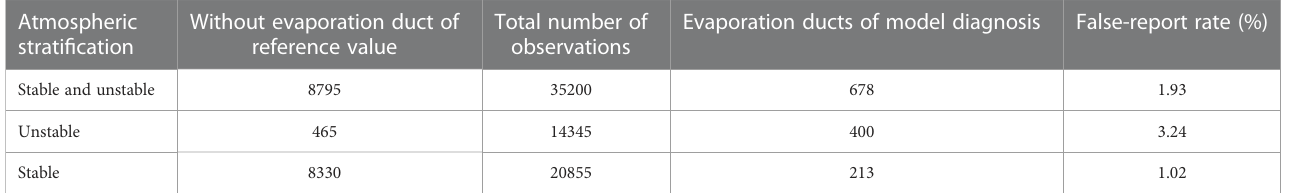
TABLE 2 Evaporation duct false-report results.